Question: Looking at the figure, what chart type is it?
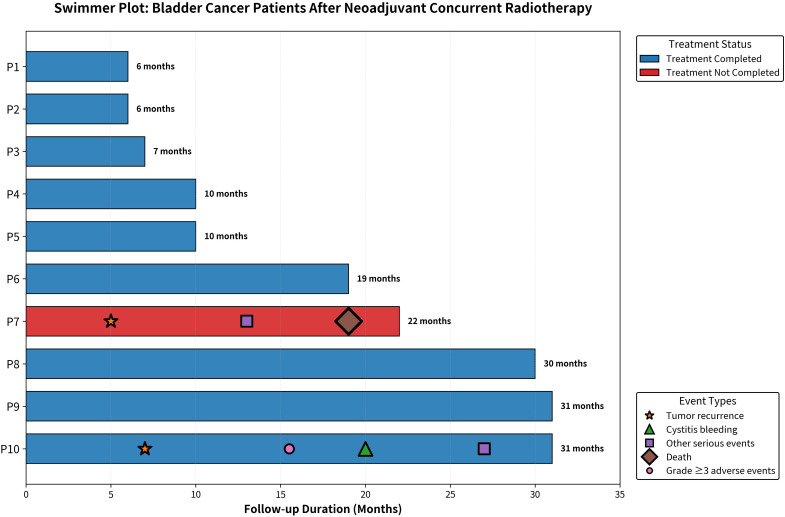
Answer: survival